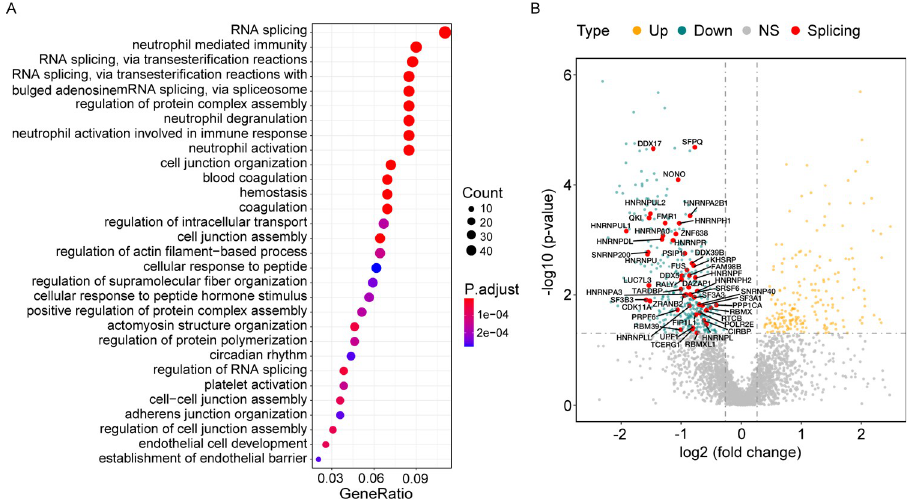
Fig 2. Proteomic profiling reveals dysregulated proteins in the lungs of COVID-19 patients. (A) Dotplot visualization of the top 30 enriched GO terms of downregulated proteins. Fisher’s exact test using enrichGO function in R package clusterProfiler. (B) A volcano plot (p value vs fold change) comparing gene expression in cases versus controls is shown at protein level. Up- and downregulated proteins are highlighted in orange and green, respectively and RNA splicing related proteins that are differentially expressed are named. The horizontal dashed line represents an adjusted p value of 0.05 (Wald test in DESeq2, multiple test correction by Benjamini-Hochberg (BH)), and the vertical dashed lines represent log2FC of -0.26 and